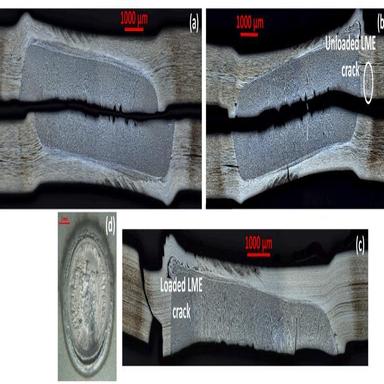
Metallographic observations of fractured samples: a) free of LME inner crack, b) with an unloaded LME inner crack, c) with a loaded LME inner crack. d) Top wiew of the fracture surface of the loaded-crack sample.